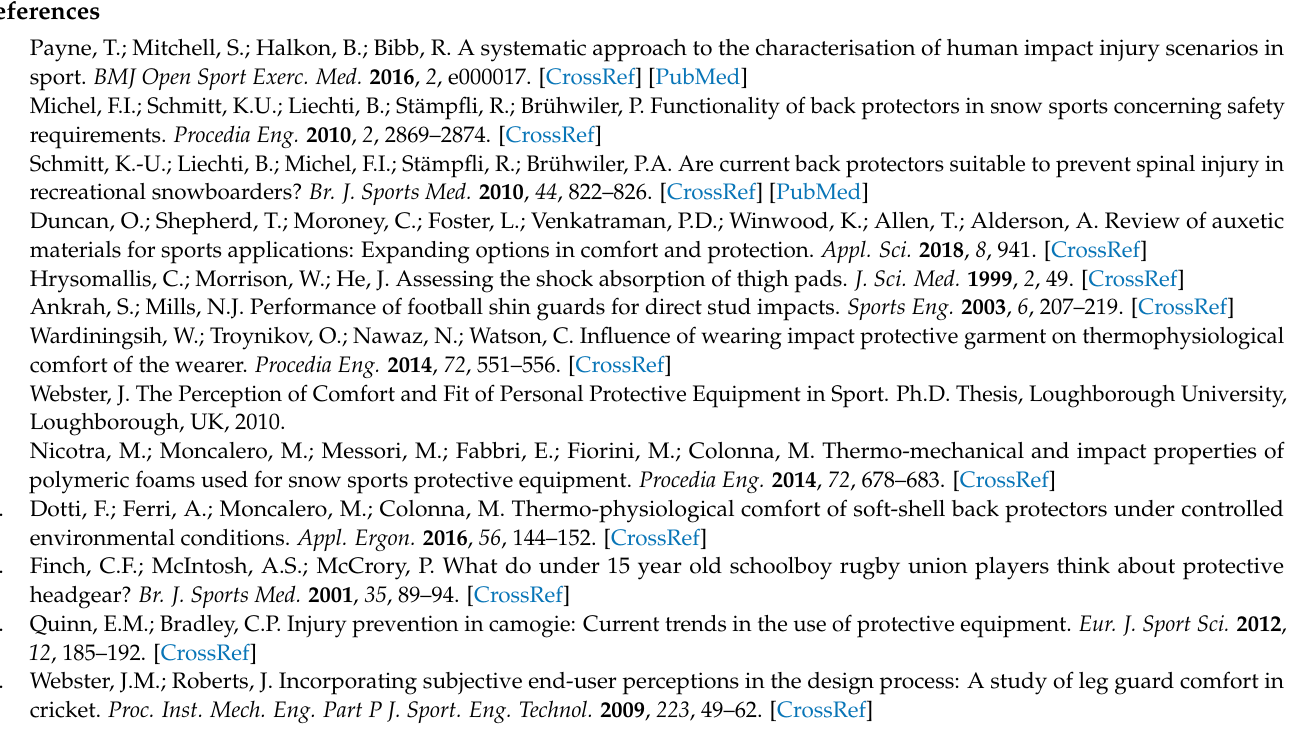
Table S1: Summary data, Video S1: DIC Video (Anisotropic